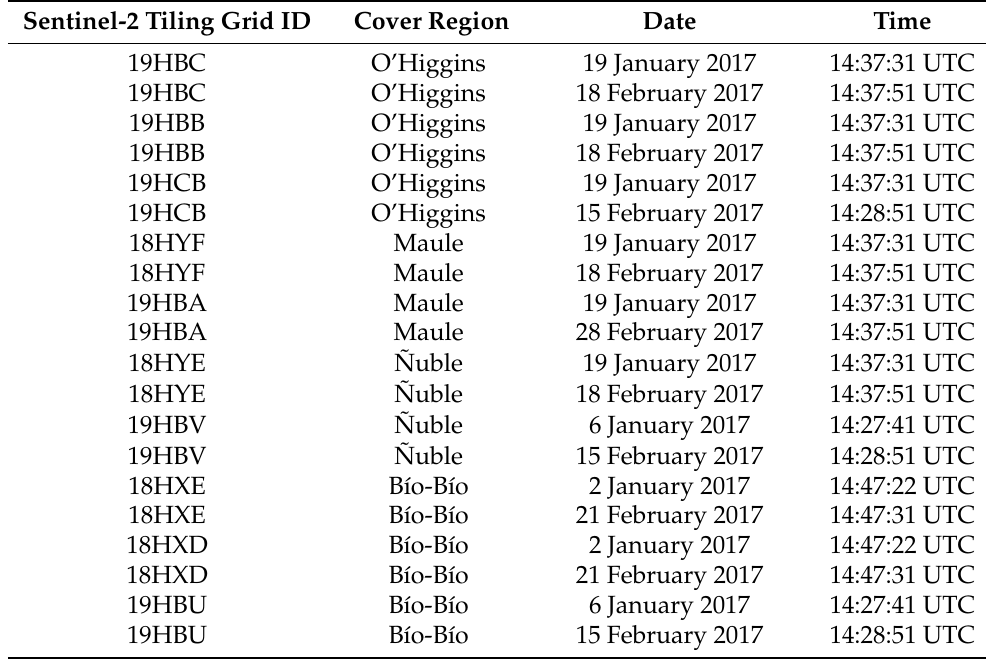
Figure 2. Infrared false-color composite, red and black tones, show unburned and burned vegetation, respectively ( A ). Spectral signature of unburned and burned vegetation ( B ). Table 1. Sentinel-2 images ID Tiles, cover region, date and time of